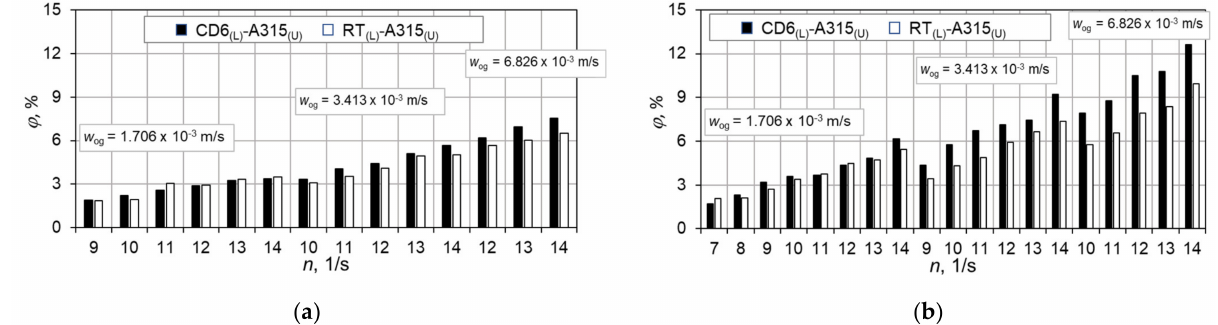
Figure 7. Dependence of ϕ = f( n ) for two different impeller configurations CD6 (L) -A315 (U) or RT (L) - A315 (U) and for two different gas–liquid systems: ( a ) air–water system, ( b ) air–aqueous solution NaCl of concentration c = 0.8 kmol/m 3